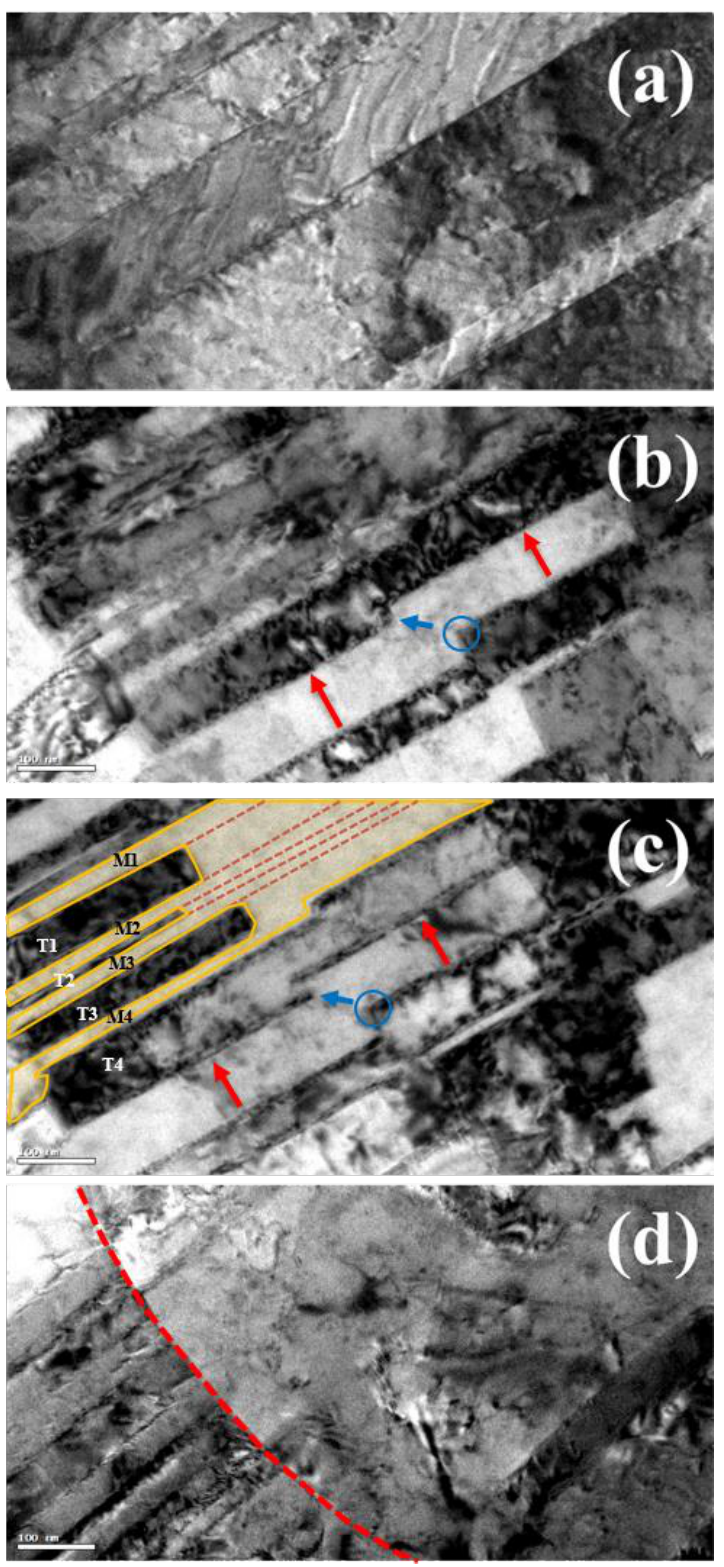
Figure 4. ( a ) is the initial twin structure of the nt-Cu film, ( b ) reveals a ledge occurring in the twin laminar crystal, ( c ) shows the movement of the ledge leading to the collapse between two opposite twin-boundaries, and ( d ) shows the de-twinned region . As shown in Figure 4d, the de-twinned region is shown in the area on the right of the red dashed line. In the region right next to the red dash line, the initial twin boundaries in